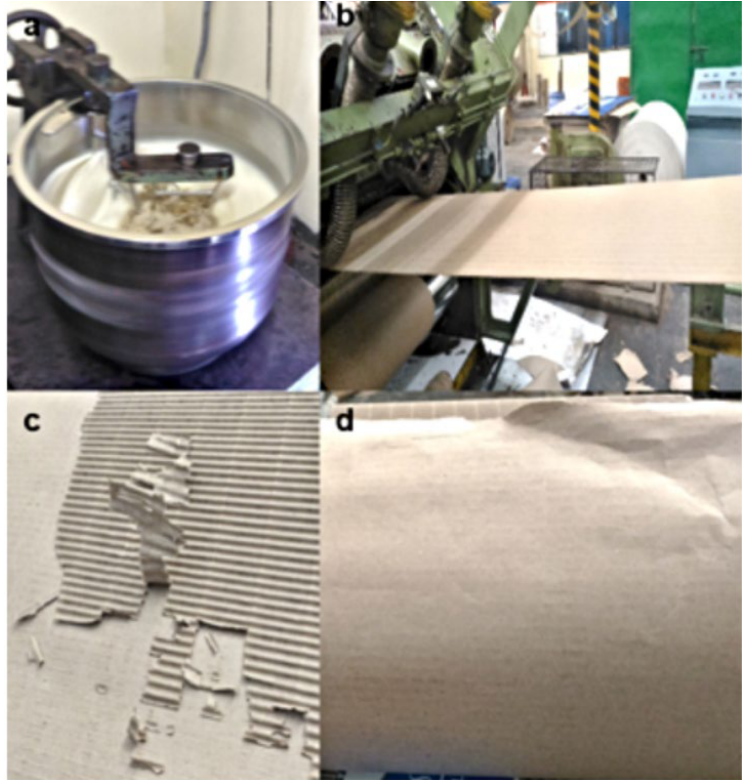
Fig. 6. Factory trial of LPE+Nisin mixture (0.06% w/w) on the cardboard boxes. A. Mixing of starch based glue with LPE+Nisin B. Spread coating of LPE+Nisin to corrugated cardboard on a roller tray C. Observation of spoilage free cardboard after 90 days D. Observation of spoilage free cardboad after 180